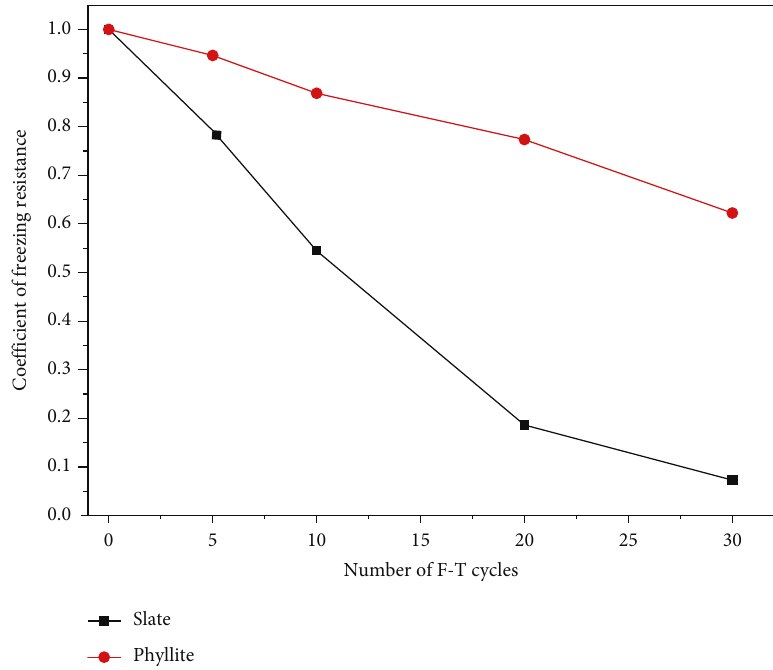
Figure 8: Relationships between coe ffi cient of freezing resistance and number of F-T cycles of two low-grade metamorphic